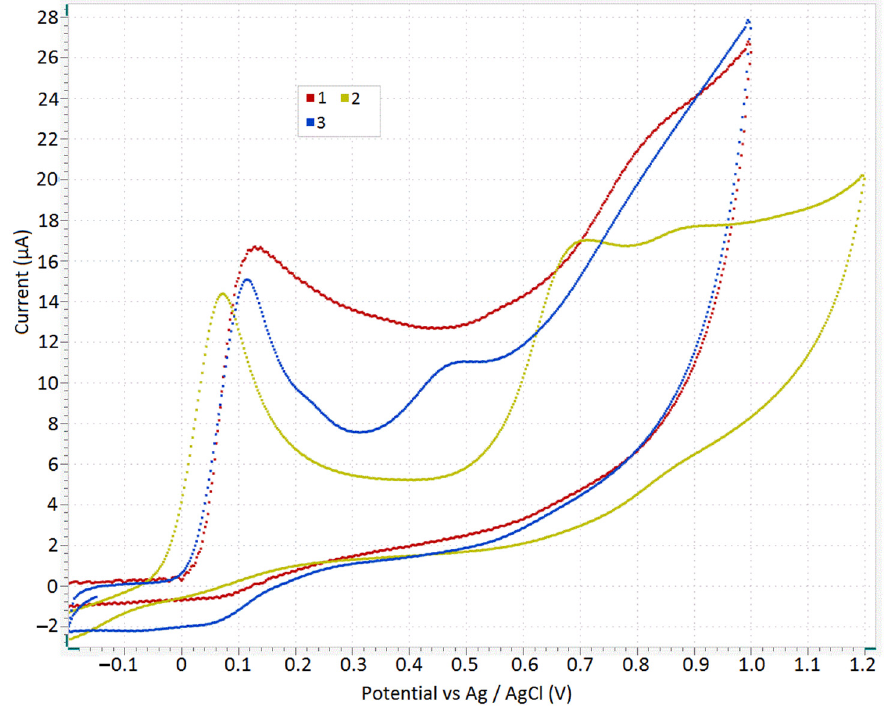
Figure 2. Cyclic voltammograms of Dihidromyricetin (1), Baicalein (2), and Quercetin (3) recorded on a glassy carbon electrode, reference electrode—silver chloride electrode, C AO = 0.1 mM. Background: phosphate buffer solution–ethanol 1:1. Scan rate is 0.05 V/s.